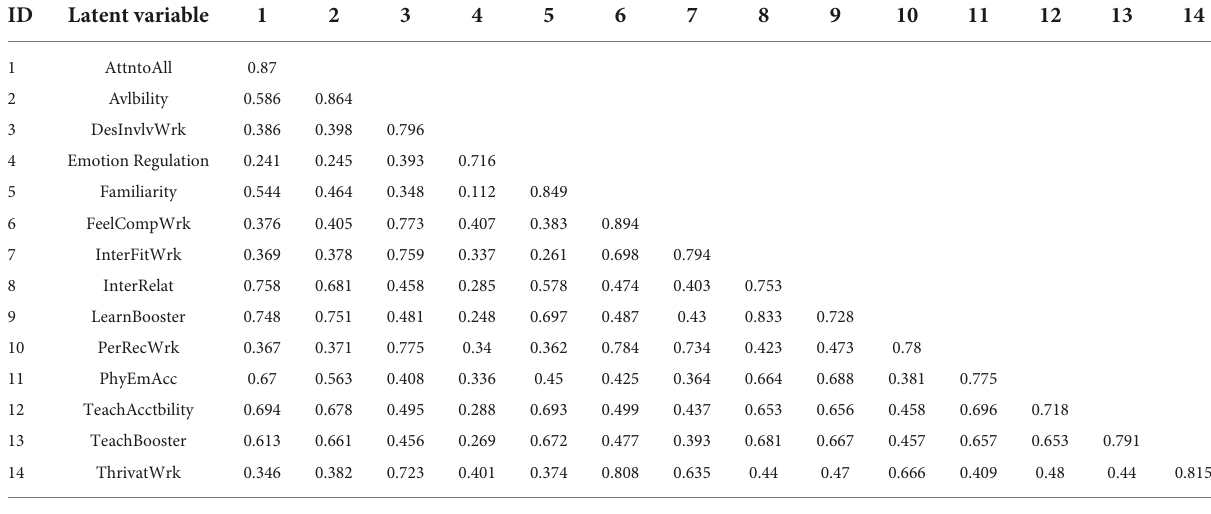
TABLE 5 The results of Heterotrait–Monotrait